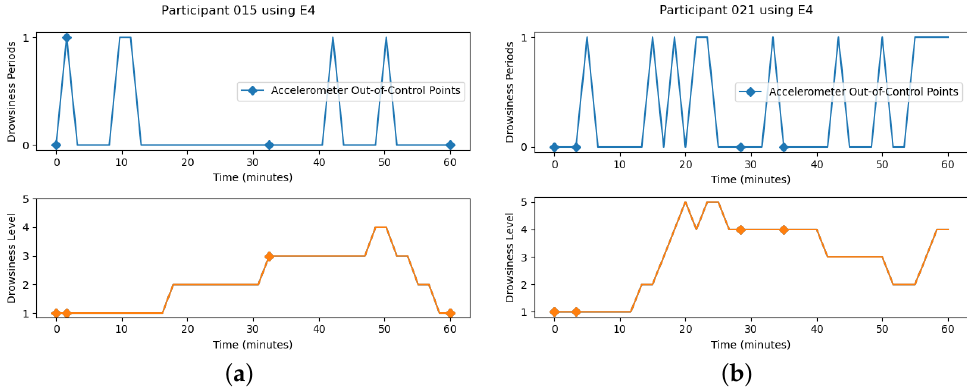
Figure 7. MSPC-PCA Methodology and Drowsiness Classification. ( a ) participant 15. ( b ) participant